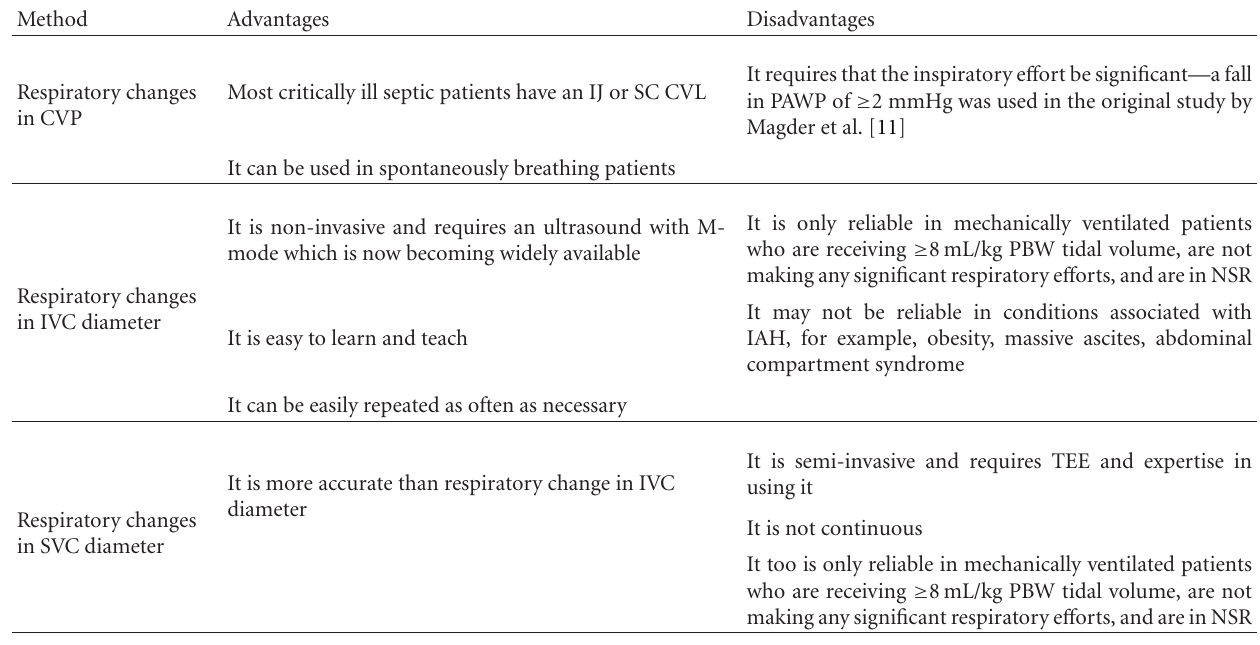
Table 4: Advantages and disadvantages of the various dynamic parameters used to predict preload responsiveness.